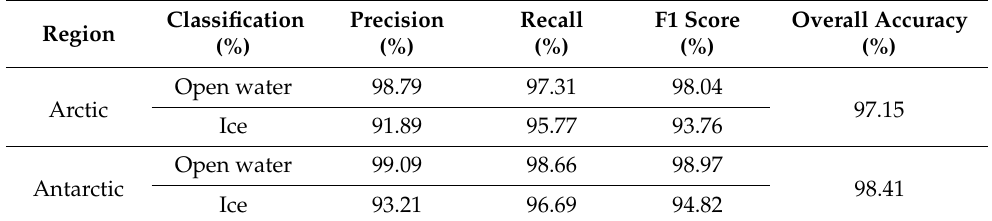
Table 4. Summary of averaged classification accuracies obtained using an SVM classifier in the Arctic and Antarctic from 2019 to 2021.